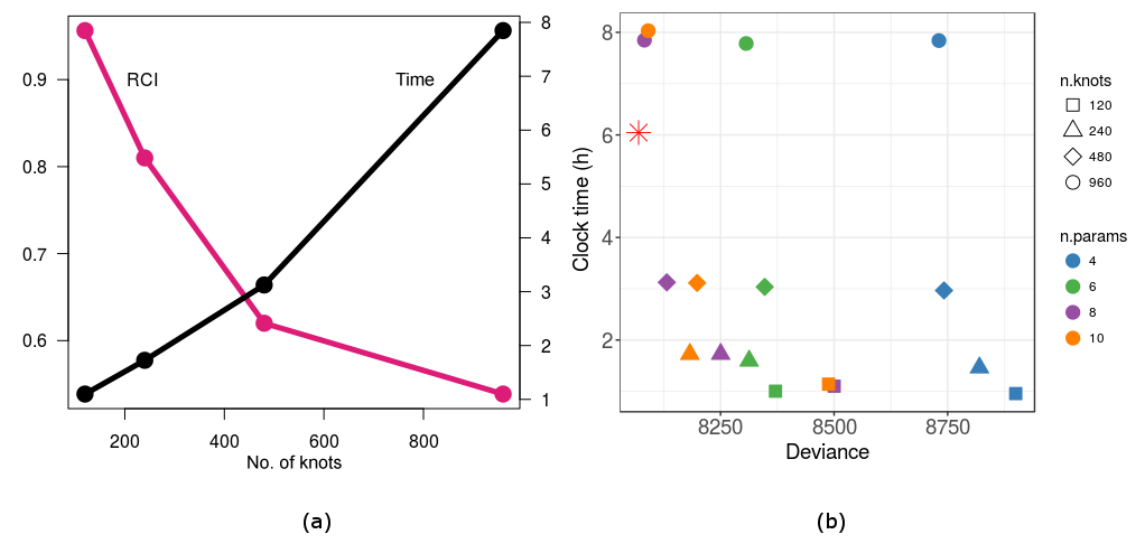
Figure 7. Results of the scaling experiment. (a) Trade-off between wall-clock time and the approximation error (relative confidence interval, RCI) with increasing emulator knots. (b) The trade-off between improved model–data agreement and wall-clock time. The red star is the emulator design followed in this study for SIPNET with eight model parameters and 729 knots. Underlying data for (b) can be found